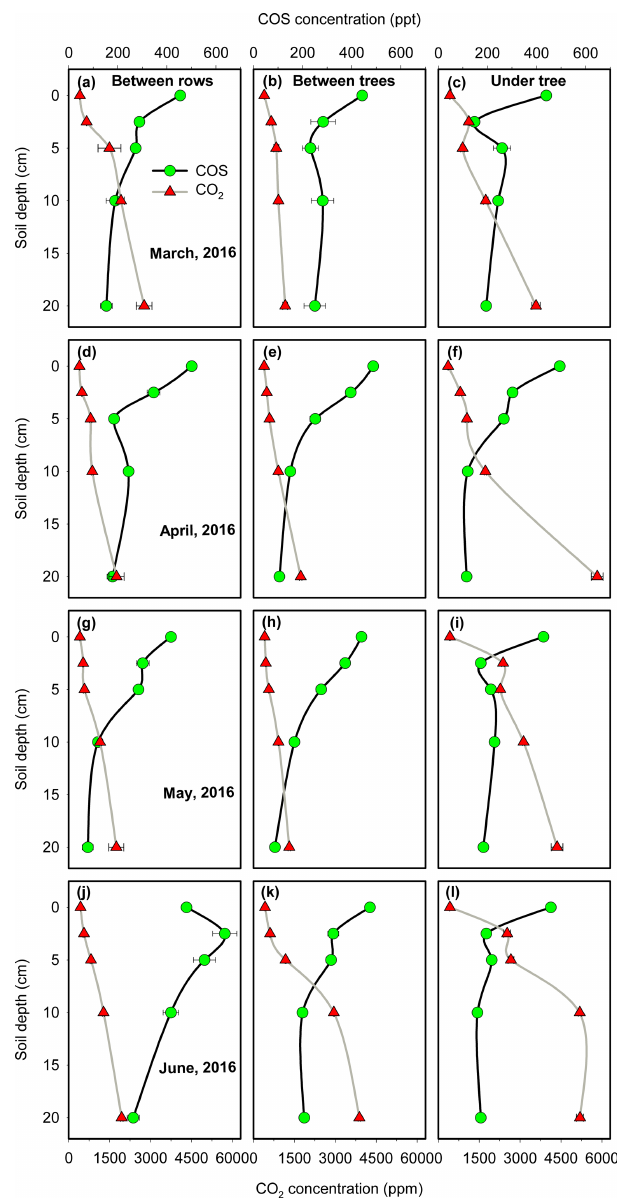
Figure 5. Soil COS and CO 2 concentration profiles at the three micro-sites in four measurement campaigns. The data points are the mean of all measurements in a campaign ( N = 4, ± 1